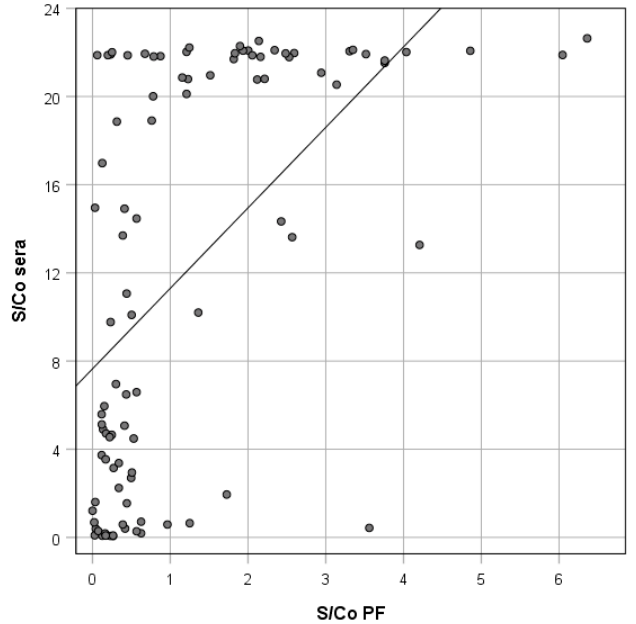
Figure 1. Scatterplot of the signal-to-cutoff (S/Co) ratio values from individual serum and processing fluid (PF) ELISA results in 95 paired samples.